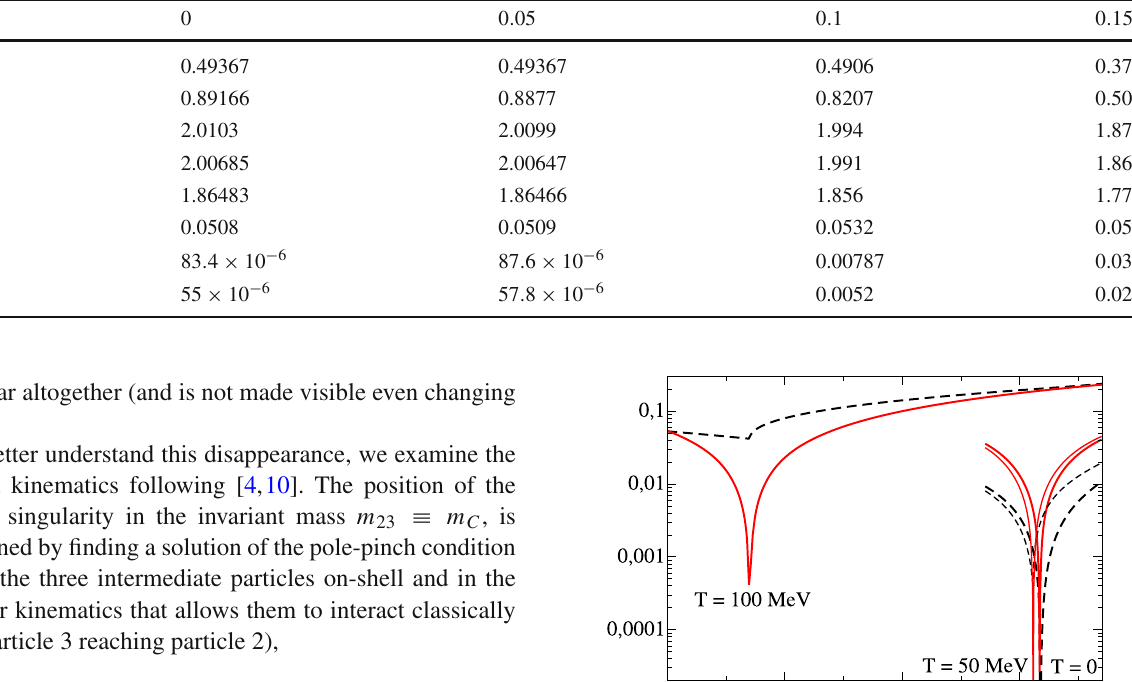
Table 1 Input meson thermal masses and widths [30–32] for increas- ing temperatures, all in GeV. We exclude m π , practically constant and with modification of unclear sign [33–35]. We are not currently aware